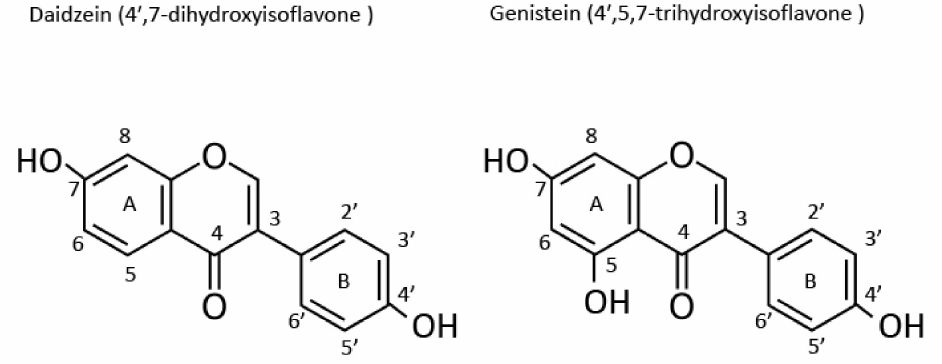
Figure 1. Structures of daidzein and